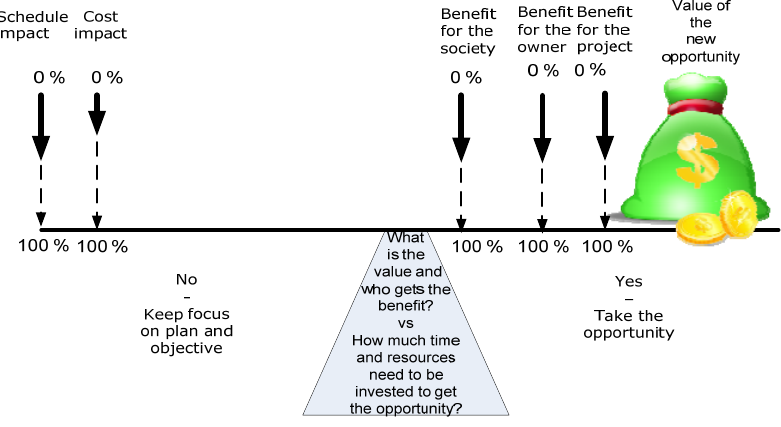
Figure 1. What is the value, and who will receive the benefit?